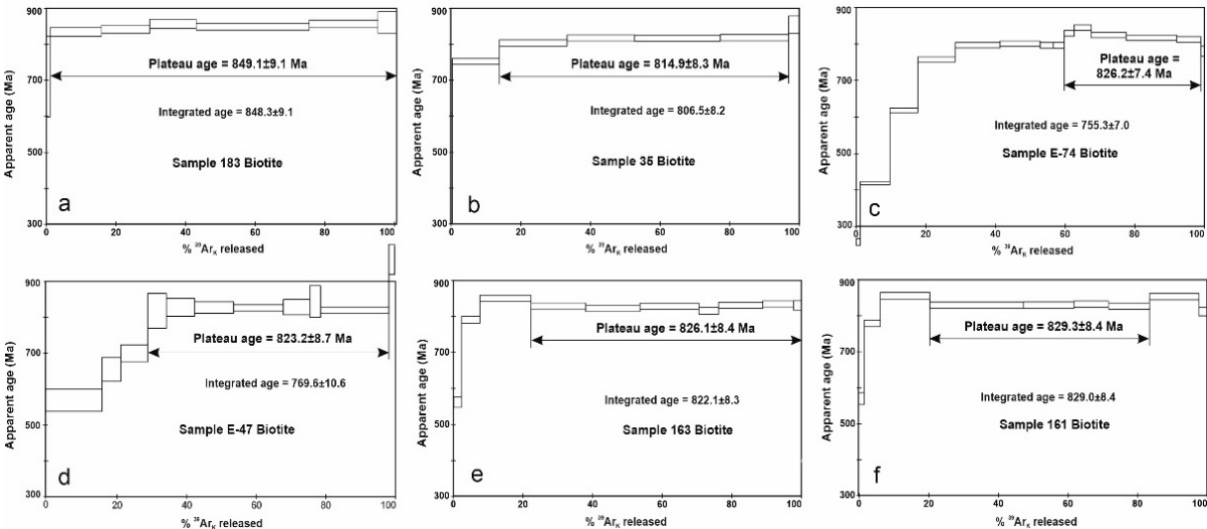
Figure 31. 40 Ar– 39 Ar mica ages for collision-related metamorphic rocks ( a ) of the Angara area, ( b ) of the Chapa area, ( c , d ) of the Mayakon area, and ( e , f ) of the Teya area. Either the plateau (arrows) or integrated age is given for each sample. Sample locations are shown in Figure 11a,c.